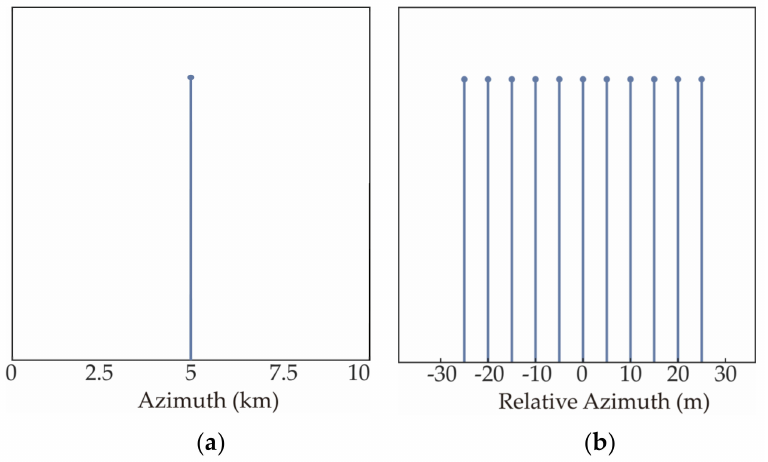
Figure 14. Targets of 11 points with 5 m equal spacing in the azimuth direction. ( a ) The whole scene; ( b ) enlarged target’s